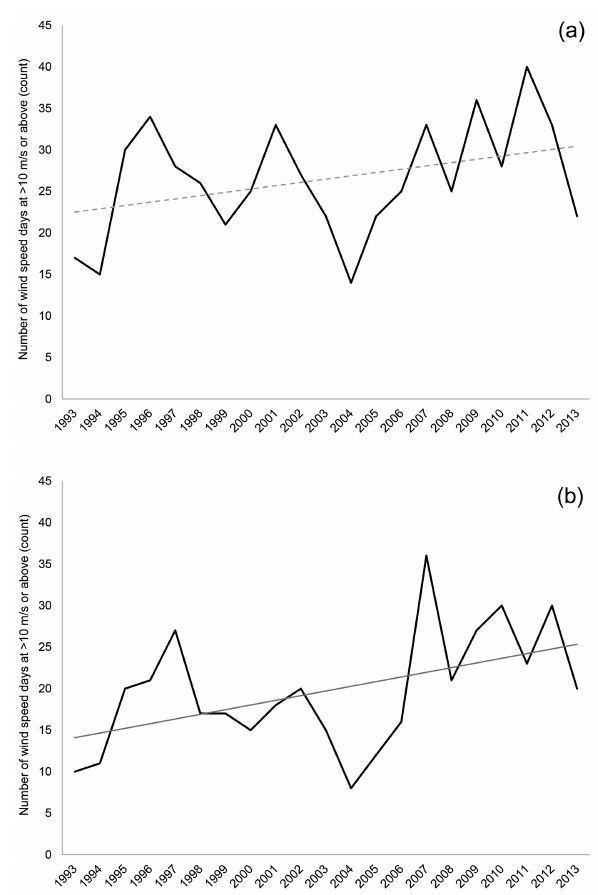
Fig. 5 . Number of extreme wind days (> 10 m/s) for austral summer months, at the (a) aggregate scatterometer data point where the upward tendency was not significant at either 5% or 10% significance levels, and at the (b) NCEP-DOE data point, where the upward tendency was significant (p =